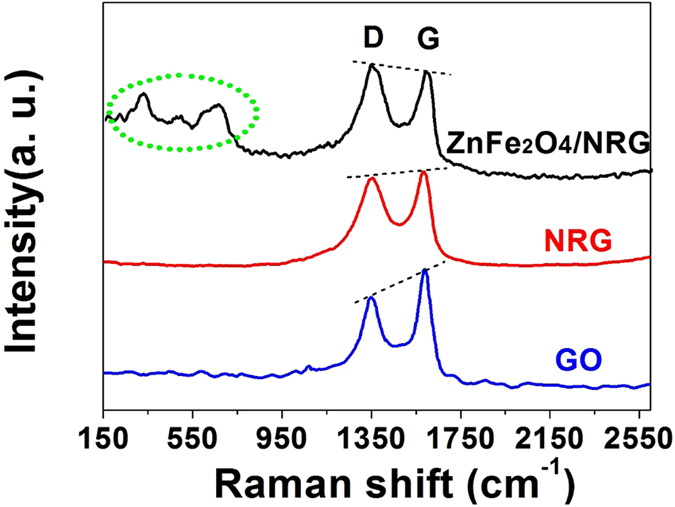
Raman spectra of GO, NRG and ZnFe2O4/NRG composite.